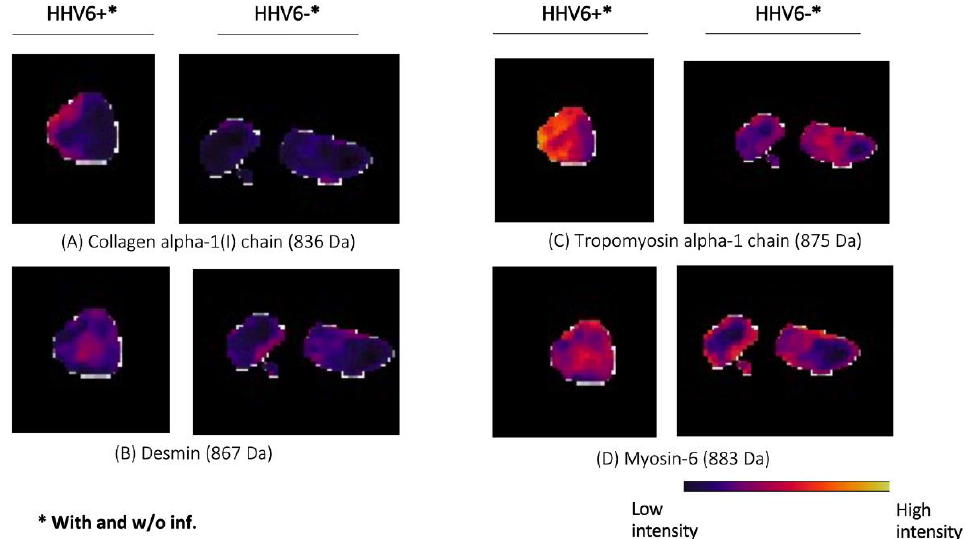
Figure 6. Endomyocardial biopsies of HHV6-positive and -negative patients display differential intensity distribution in selected proteins. Relative peptide expression (color bar) is shown for MALDI m / z ion peaks of ( A ) collagen alpha-1(I) chain (836 Da), ( B ) desmin (867 Da), ( C ) tropomyosin alpha-1 chain (875 Da), ( D ) Myosin-6 (883 Da) chain (833 Da), which are higher in endomyocardial biopsy tissue from HHV6-positive patients compared to the virus-negative patients. (AUC > 0.6, <0.4 p < 0.001).